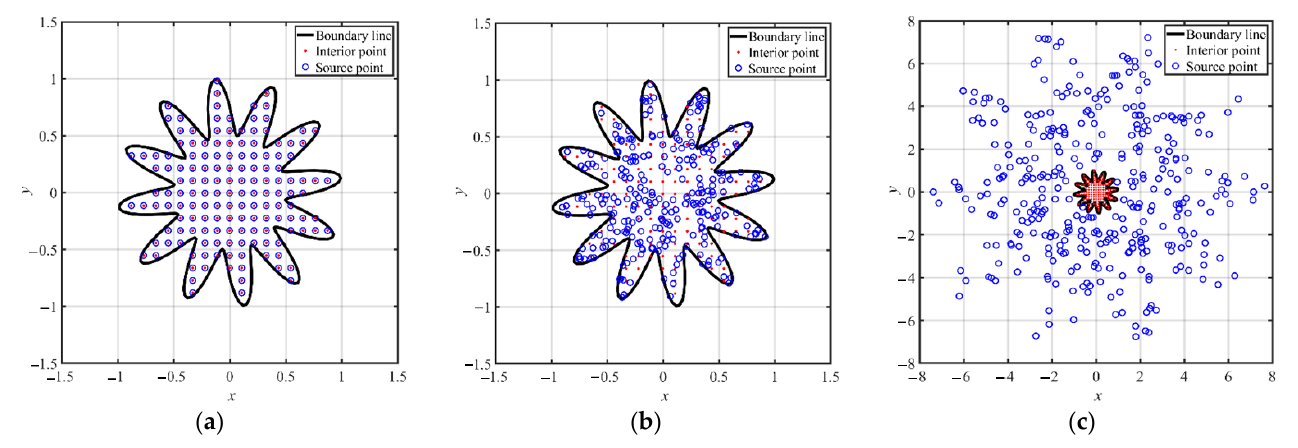
Figure 6. Collocation points for application example 1. ( a ) Type A. ( b ) Type B. ( c ) Type C.